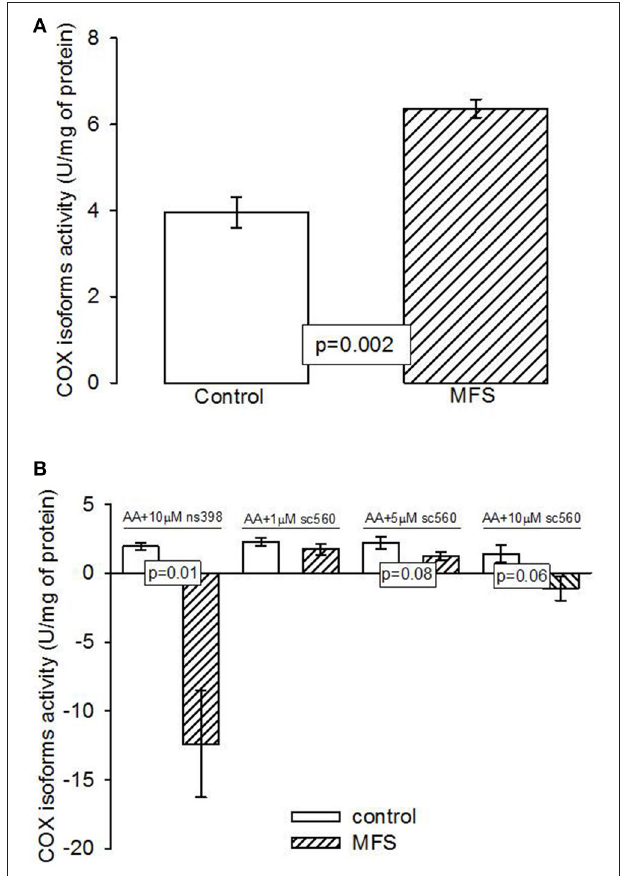
FIGURE 2 | (A) Cyclooxigenases activity in the aneurysm of the aortic homogenate in control subjects ( n = 6) and MFS patients ( n = 14). (B) Inhibition of the cyclooxygenases in control subjects ( n = 6) and MFS patients ( n = 14). Data are means ± SE. COX, Cyclooxygenases; MFS, Marfan syndrome; NS398, specific inhibitor of cyclooxygenase 2; SC560, specific inhibitor of cyclooxygenase 1. The activity was determined by an oximeter coupled with a Clark type electrode and the time stroke was